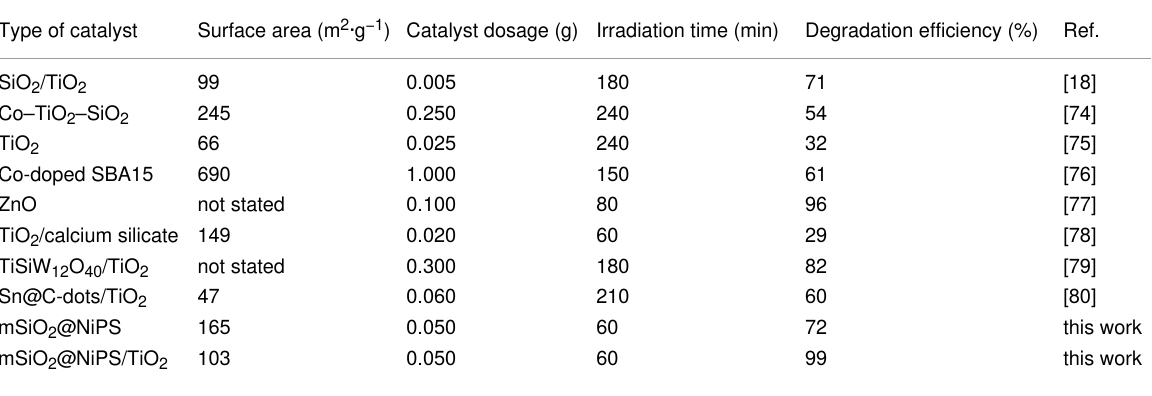
Table 2: Comparison of the photoactivity of the mSiO 2 @NiPS and mSiO 2 @NiPS/TiO 2 core–shell nanostructure with other catalysts for the degrada- tion of methyl violet dye. Type of